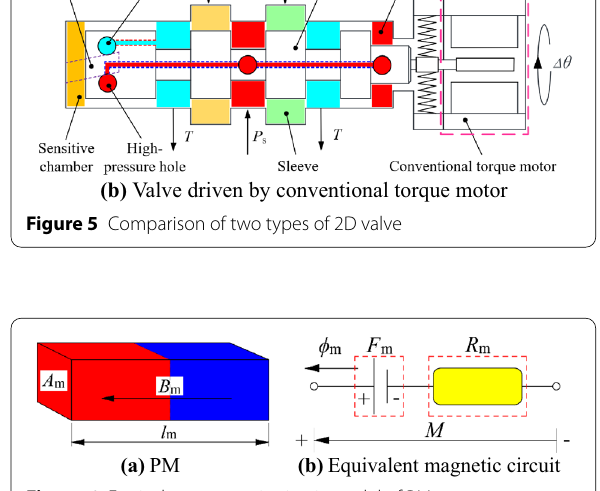
(a) Valve driven by REMC-NFM